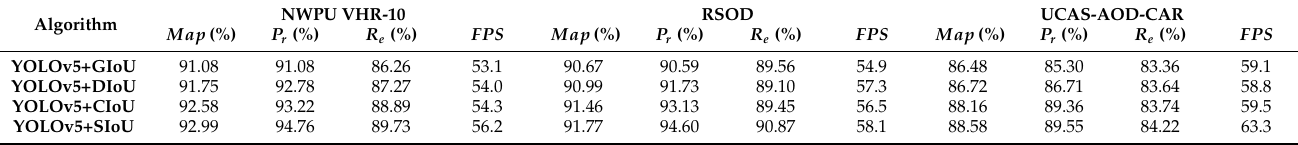
Table 8. The detection results after adding several advanced loss functions in